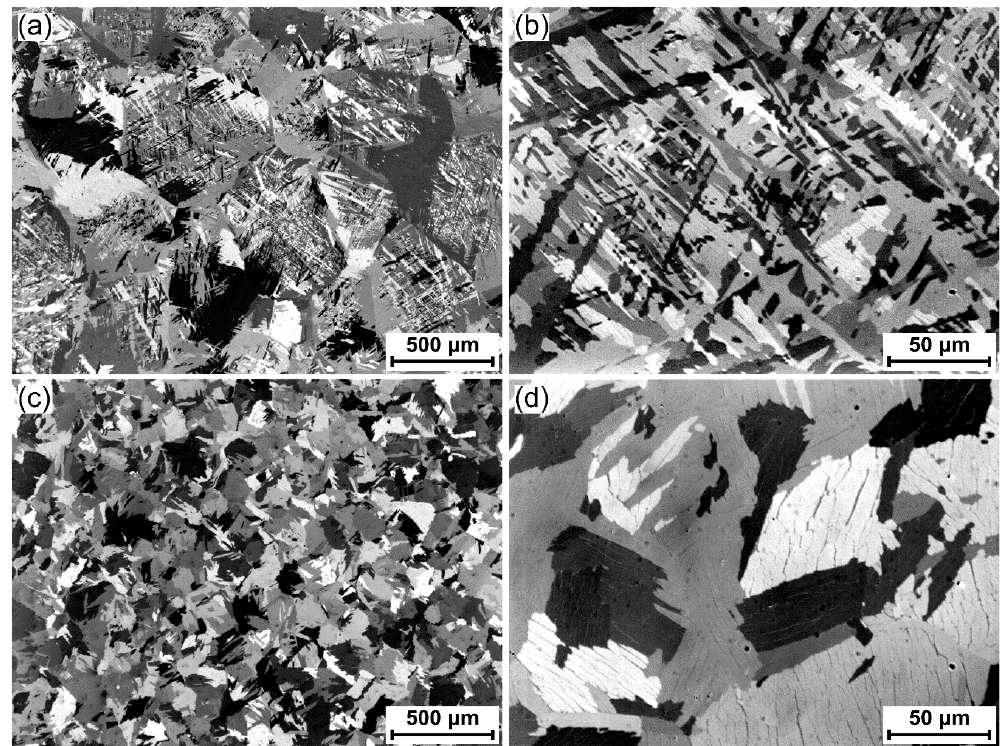
Figure 6. Cross-polarized light micrographs showing the microstructure of a 60 mm diameter disc of Ti-6Al-4V swarf after FAST processing at 1200 °C for 30 min: ( a ) low magnification; ( b ) high magnification. For comparison, cross-polarized light micrographs showing the microstructure of a 100 mm diameter disc of Ti-6Al-4V HDH powder after FAST processing at 1200 °C for 30 min: ( c ) low magnification; ( d ) high magnification.